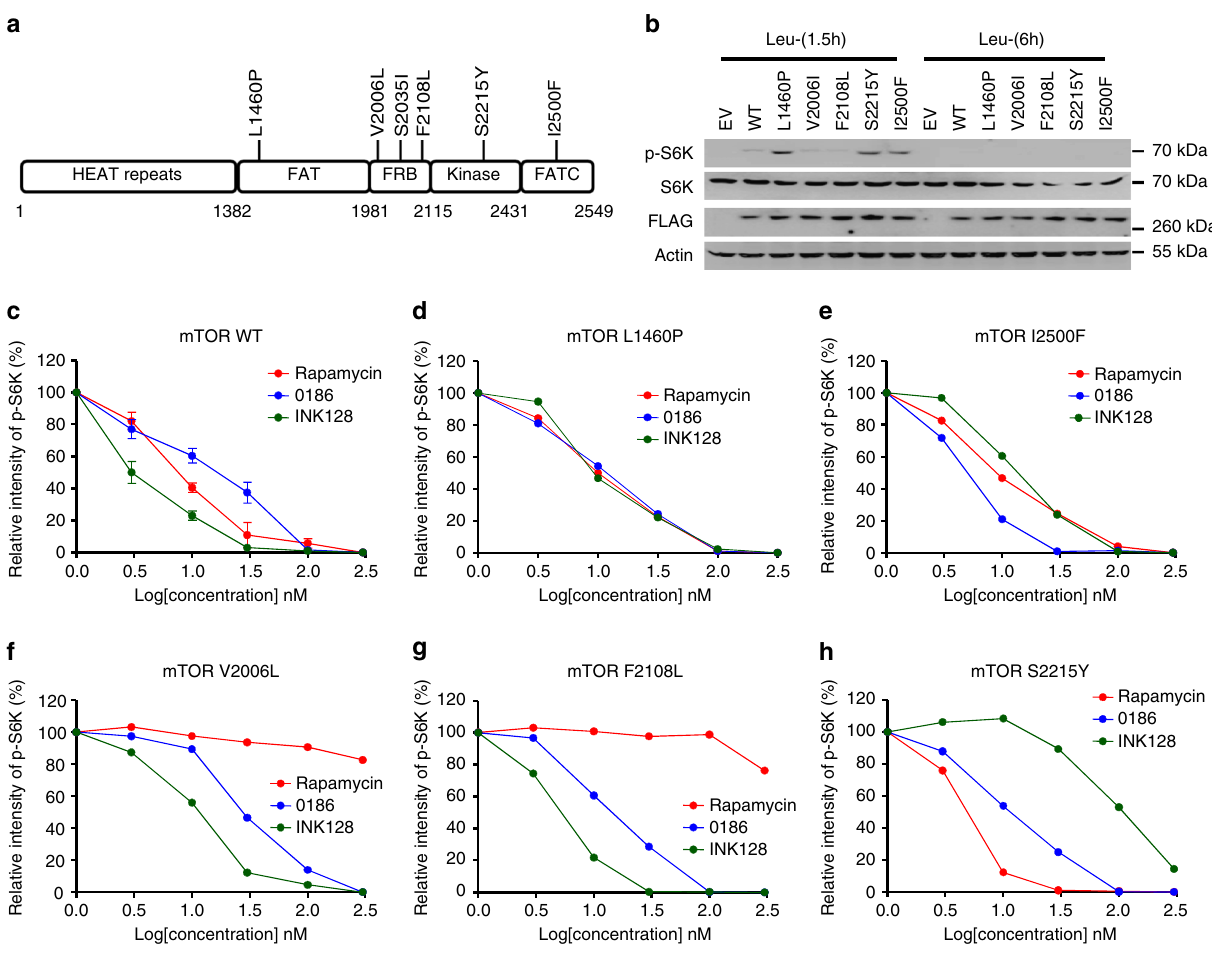
Fig. 6 Effect of BC-LI-0186 on cancer-associated MTOR mutations. a Schematic representation of cancer-associated MTOR mutations. b Leucine- dependency of cancer-associated MTOR mutations. SW620 cells were transfected with FLAG-tagged mTOR WT and the indicated mutants. The cells were starved for leucine for 1.5 and 6 h, and the cell lysates were analyzed with the indicated antibodies. c – h Effect of BC-LI-0186 on S6K phosphorylation in SW620 cells harboring mTOR WT ( c ), mTOR L1460P ( d ), mTOR I2500F ( e ), mTOR V2006L ( f ), mTOR F2108L ( g ), mTOR S2215Y ( h ). The levels of